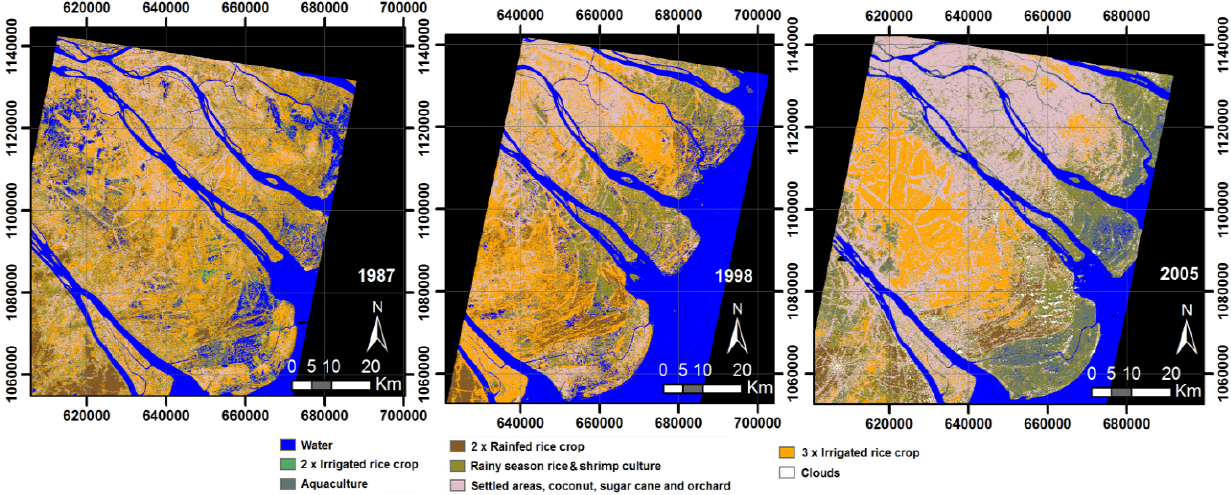
Figure 3. The land-use classifications from the SPOT imagery.